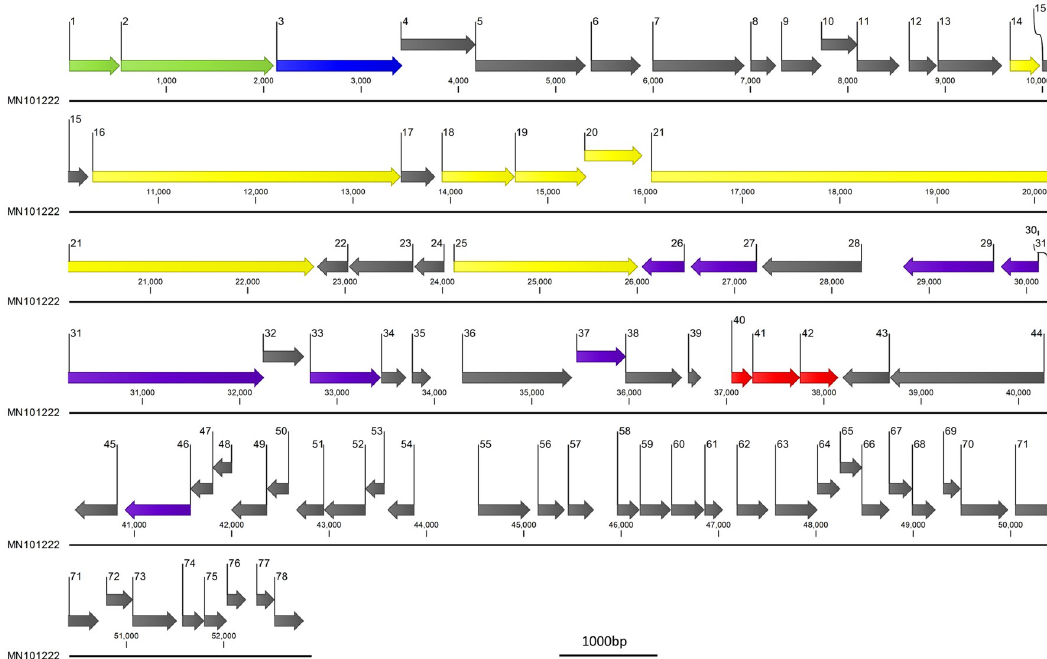
Fig 3. KMI8 (MN101222) genome. Arrows indicate putative ORFs (numbered) and direction of transcription. Grey arrows indicate putative hypothetical genes; green arrows indicate putative terminase genes; blue arrow indicates putative capsid gene; yellow arrows indicate putative tail fibre genes; purple arrows indicate putative DNA manipulation and metabolism genes; red arrows indicate putative lysis genes. Scale bar = 1000bp.